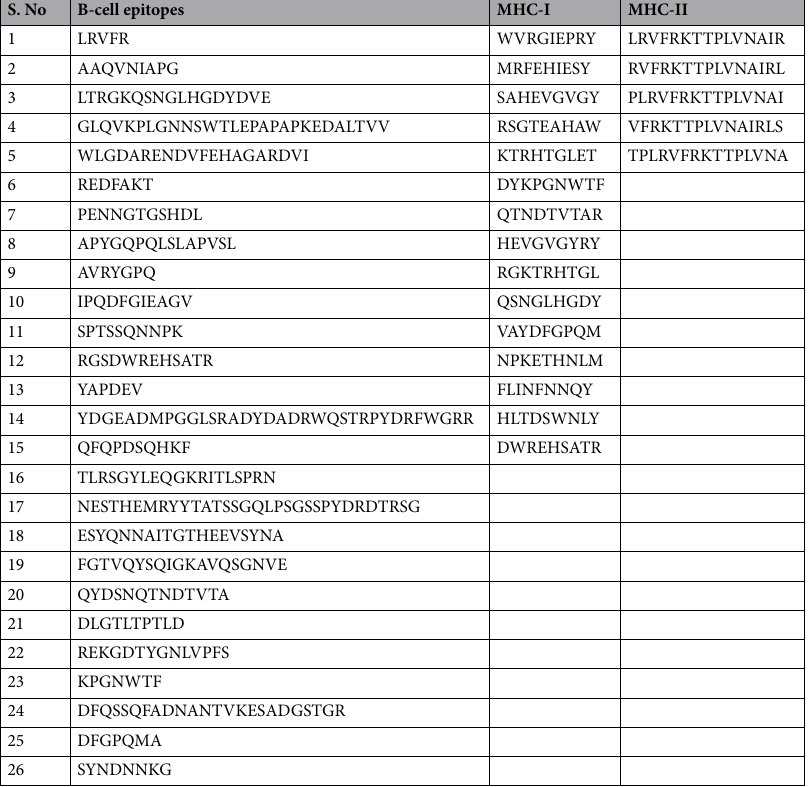
Table 3. Comparative analysis of B Cell, MHC-I and MHC-II epitopes.